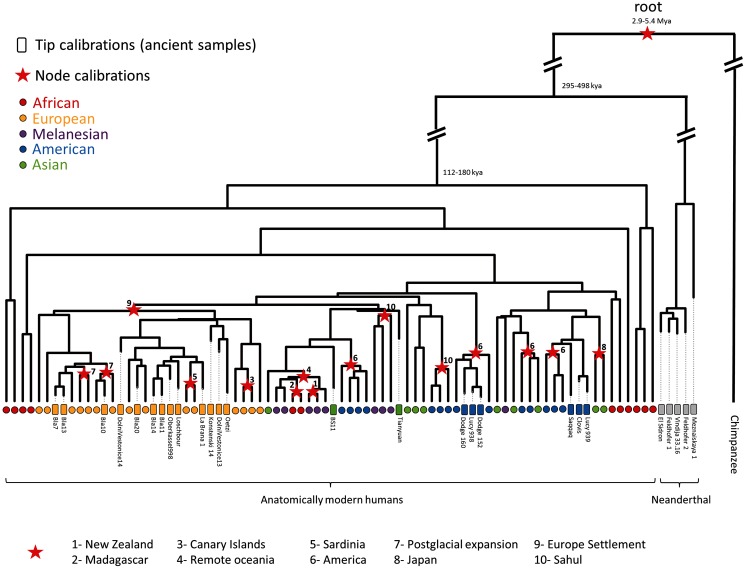
Phylogenetic tree built on a subset of both contemporary and ancient samples. This phylogeny was constructed with the BEAST software using 59 cAMHs, 21 aAMHs, and 5 archaic Neanderthals. The topology presented is well resolved as all nodes exhibit a posterior probability greater than 0.9. The end depth of branches for ancient samples reflects their ages. Ancient and contemporary samples are indicated with rectangles and circles, respectively, and colors indicate their geographical origin. Date estimates for major divergence events estimated using tips calibration are shown at the nodes. The number next to the red stars indicates the colonization/migration event associated with the node.